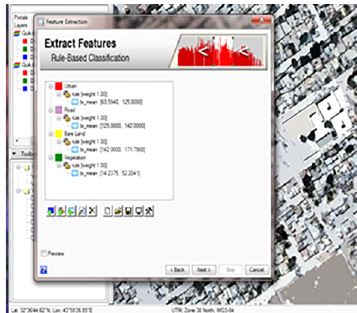
Figure 5. Extract feature based on the reflectance of textural mean